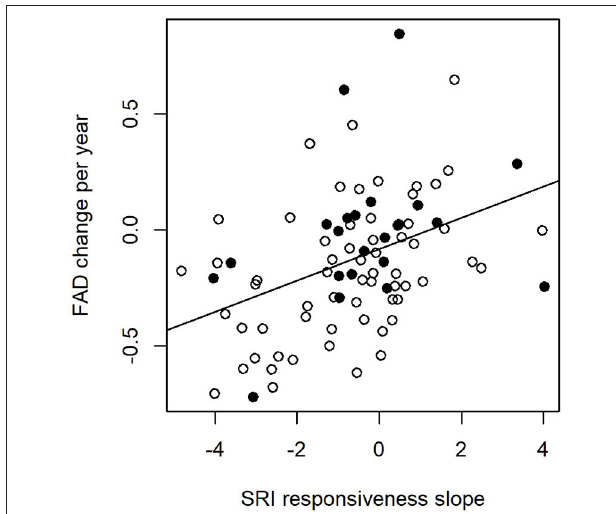
FIGURE 4 | FAD slope over time in relation to the slope of SRI responsiveness and pre-breeding molt. The regression line was fit from a PGLS model containing SRI responsiveness as single explanatory variable. More negative slopes indicate earlier arrivals in more recent years (y axis) and after wetter rainy seasons in the Sahel zone (x axis). Empty and filled circles, respectively, represent species in which pre-breeding molt is present ( N = 63) or absent ( N = 22); note that species with pre-breeding molt tend to cluster in the lower part of the